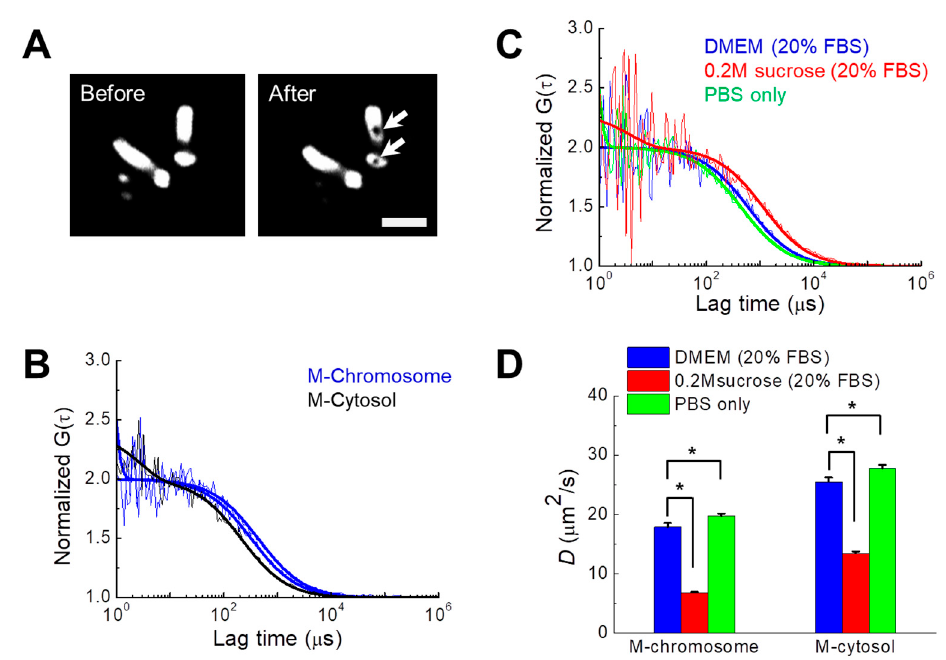
Figure 3. Changes in D values of mGFP probes in chromosomes of DM cells under different osmotic conditions. ( A ) Images of mitotic chromosomes (H2B-mRFP) during metaphase of a DM cell before and after two positions of fluorescence correlation spectroscopy (FCS) measurements. The positions of FCS measurements in the chromosome are clearly bleached (arrow), verifying the actual measured region. Scale bar = 5 μ m. ( B ) FCS analysis of mGFP expressed in a DM cell during mitosis under normal conditions. Fluorescence autocorrelation function (FAF) curves measured in a position of the mitotic cytosol and two positions of mitotic chromosome are shown. ( C ) FAF curves of mitotic chromosomes under three different osmotic conditions. For comparison of mobilities, all curves in ( B ) and ( C ) were normalized to the same amplitude, G (0) = 2. Solid lines indicate fitting of a one-component free diffusion model to the results. ( D ) Mean D values of mGFP in mitotic chromosomes and the cytosol during mitosis under the three different conditions are shown (mean ± SEM; n = 20 cells). * p < 0.01.